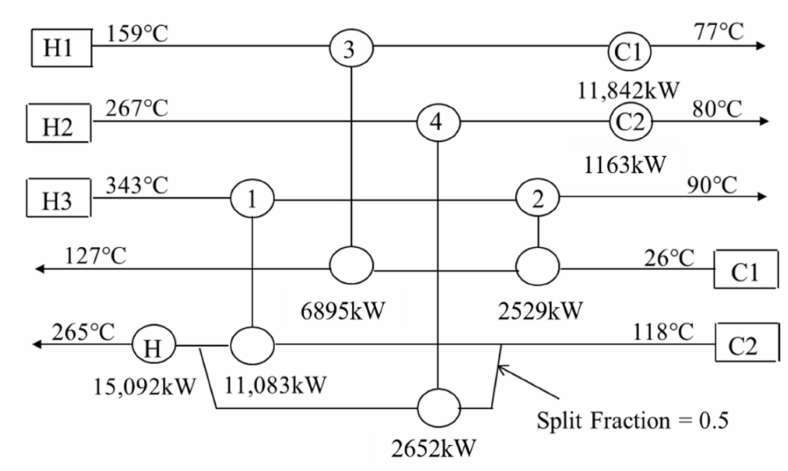
Figure 11. Apply stream splitting for case study 1.